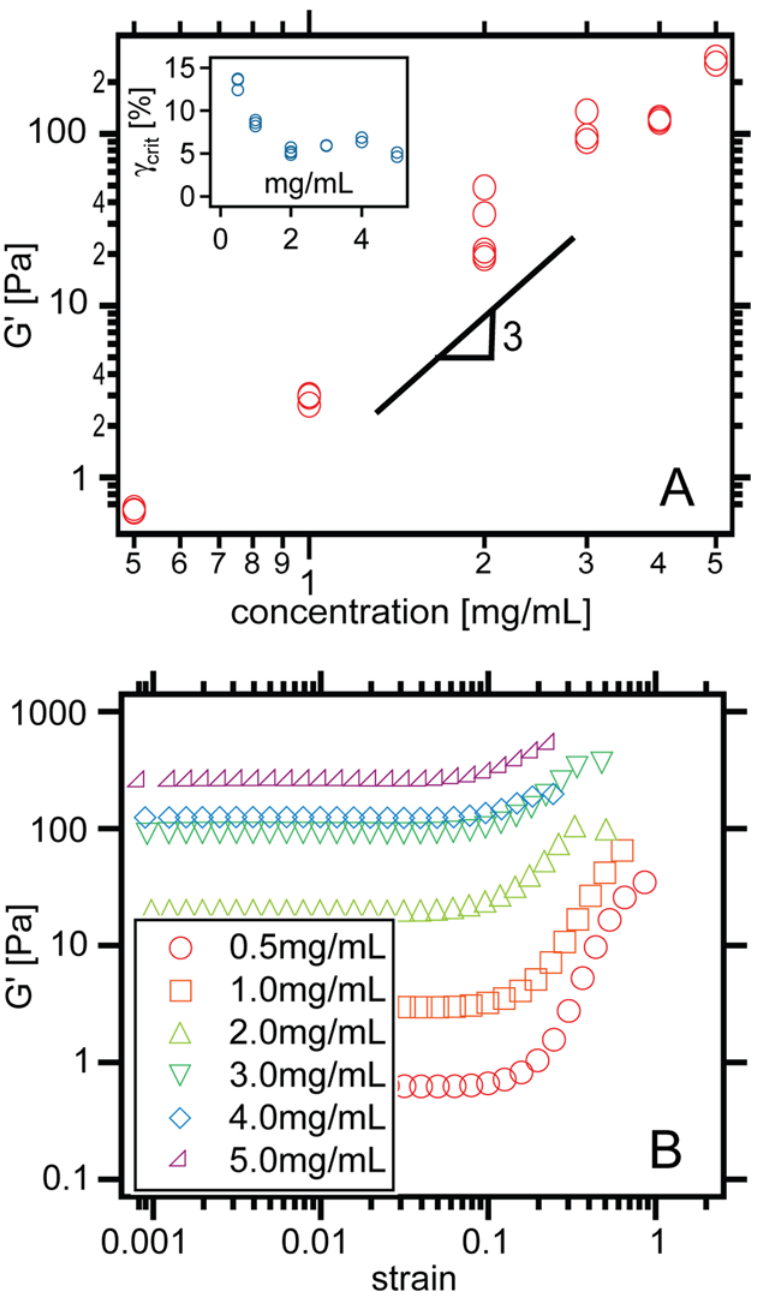
Figure 3. Bulk rheology measurements. (A) Linear elastic modulus as a function of collagen concentration. A power-law of 3 is shown for comparison. Inset: the onset of non-linear mechanical behavior, as defined in Methods. (B) Elastic modulus G ’ during oscillatory strain sweeps and as a function of collagen concentration.